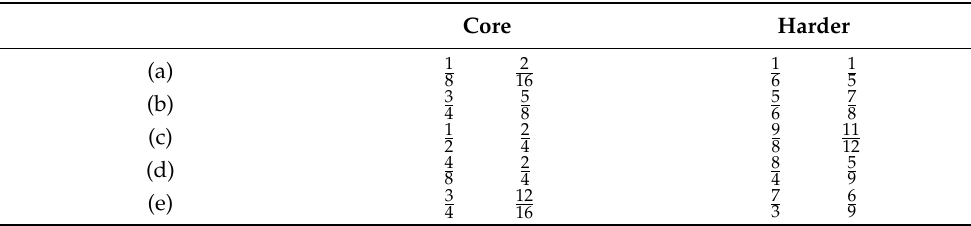
Table 7. Cases where unlike denominators were used did not increase the level of difficulty in Question